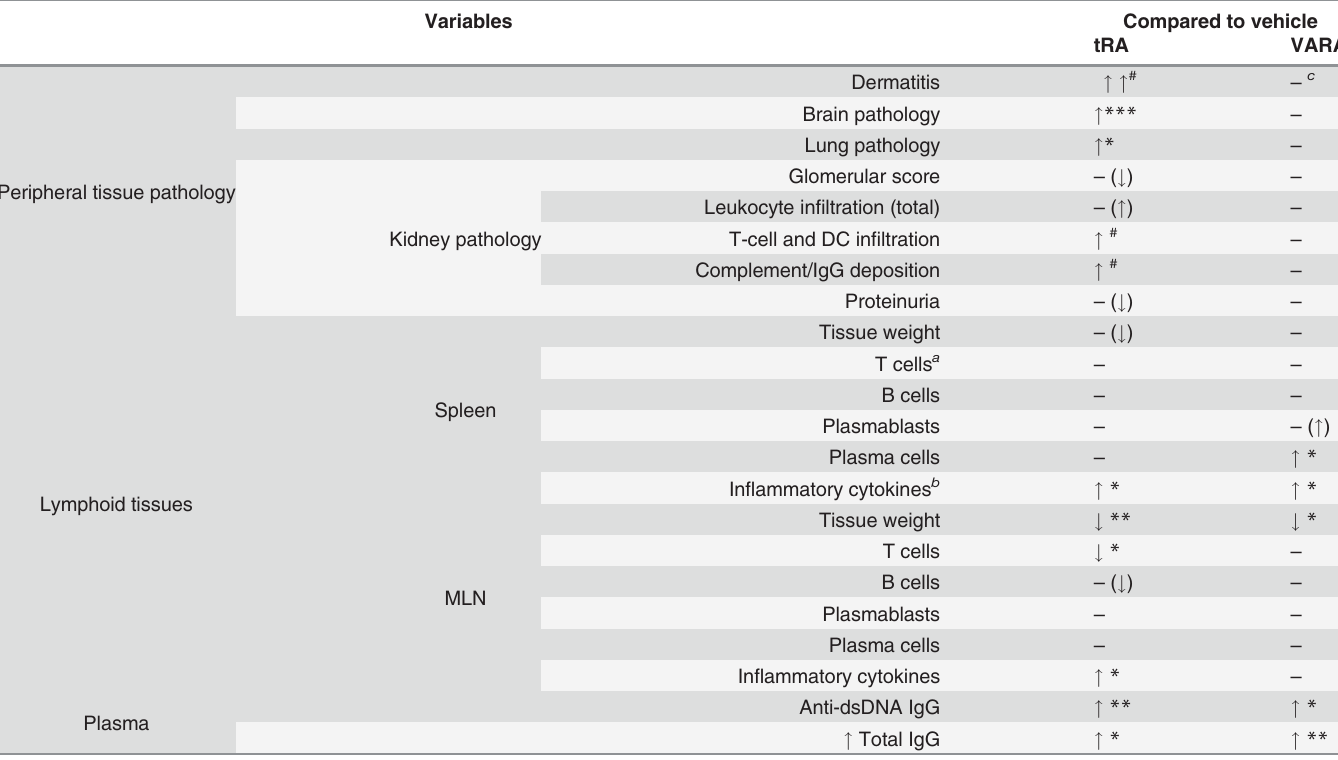
Table 1. Effects of tRA and VARA on MRL/lpr